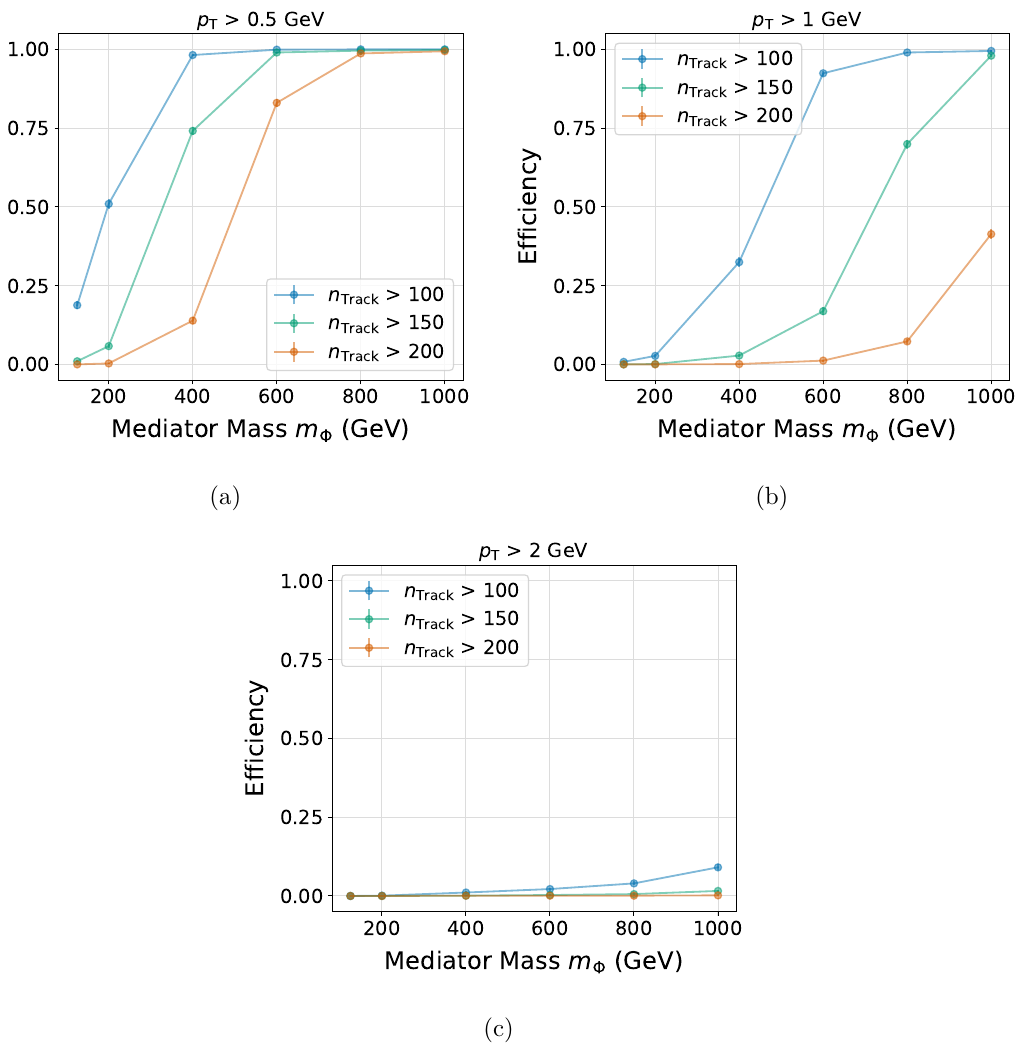
Figure 4. Efficiency, defined as number of events for which at least n Track within η < 2 . 5 pass the track reconstruction p threshold, as a function of mediator mass for minimum track p T 0.5 GeV (a), 1 GeV (b), and 2 GeV